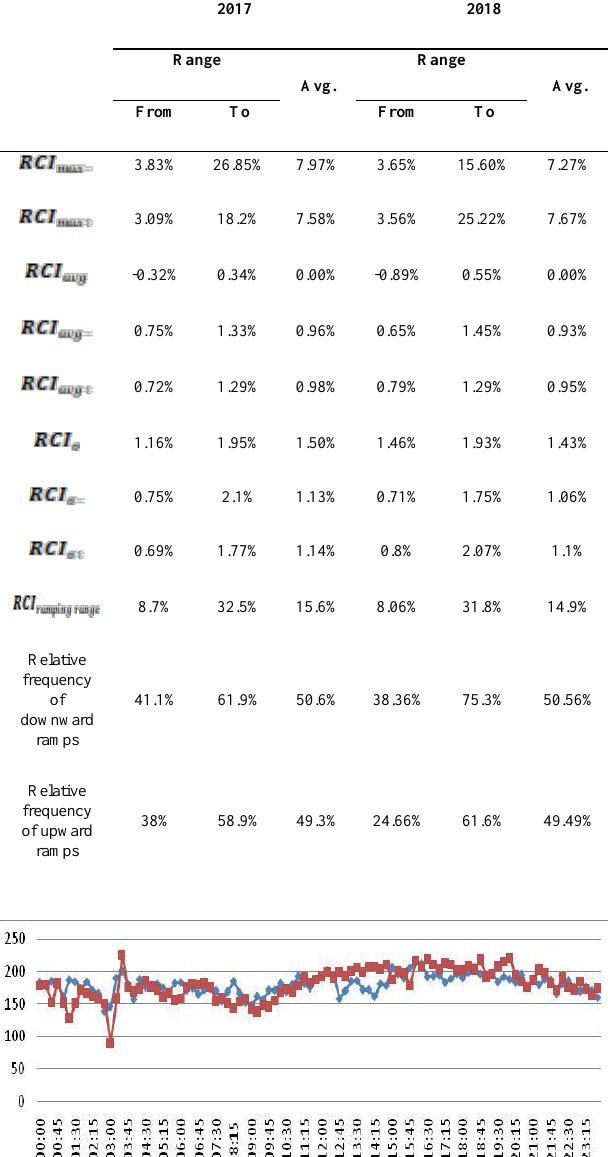
Table 2 . Vertical analysis results by RCI